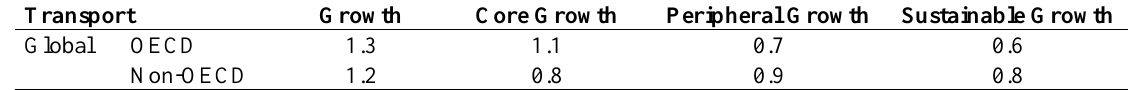
Table 10. Growth factors in the transport sector in the period 1995-2020 Transport Growth Core